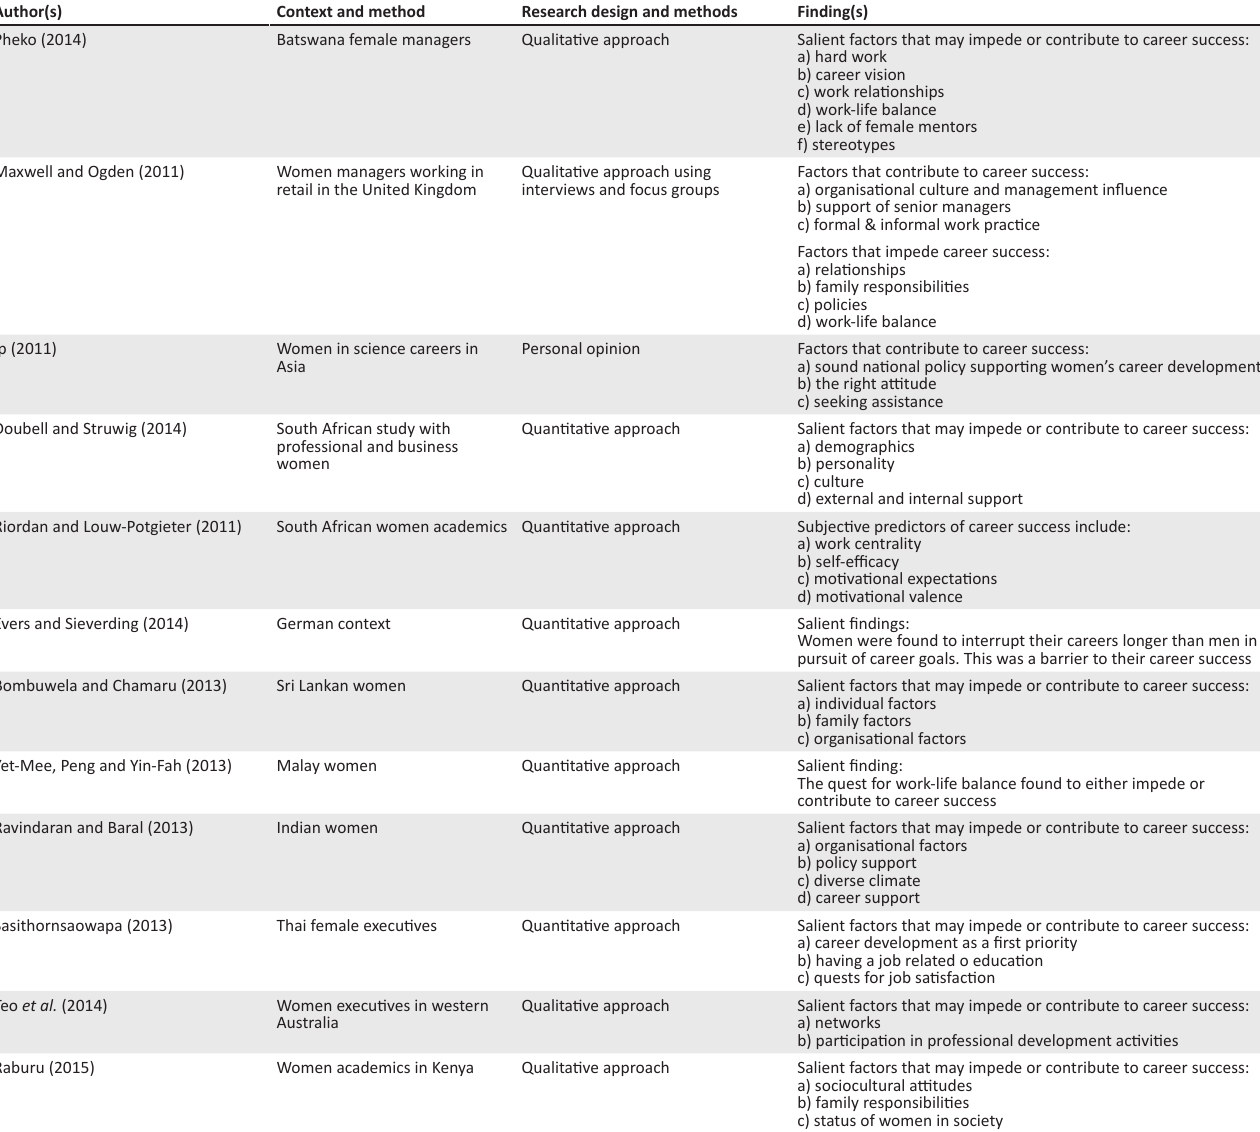
TABLE 1: Summary of South African and international studies focusing on predictors of career success amongst women.